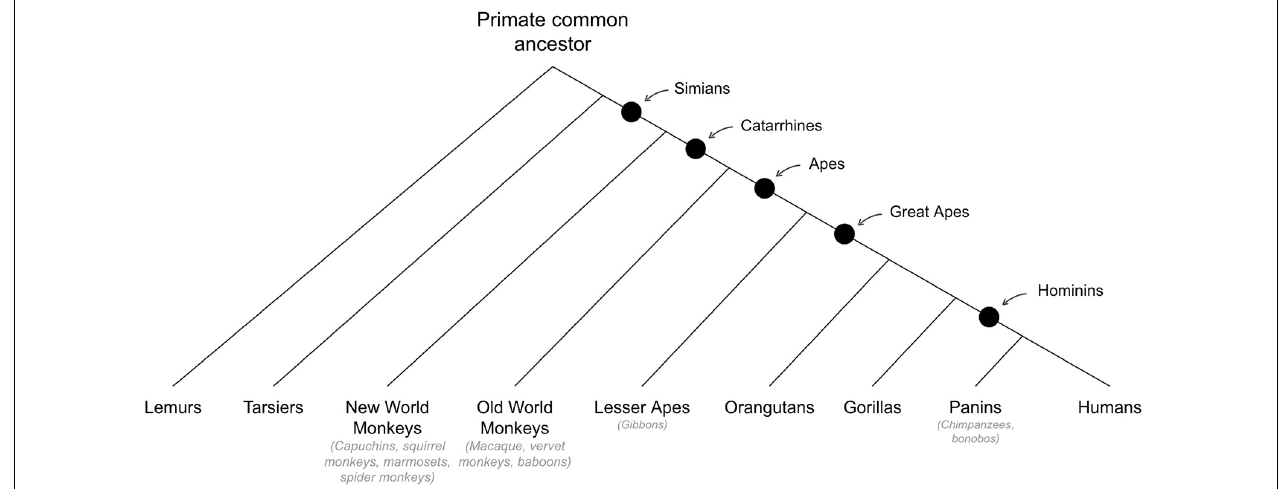
FIGURE 6 | Cladogram of primate